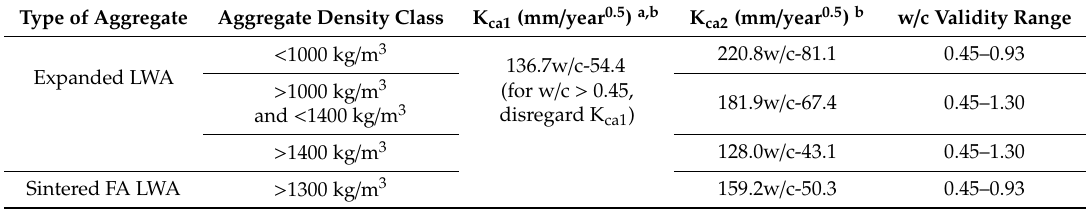
Table 1. Carbonation coefficients of stage 1 and 2, K ca1 and K ca2 , of the biphasic carbonation model, for SLWAC with different types of LWA as a function of the w/c (adapted from [101]) .